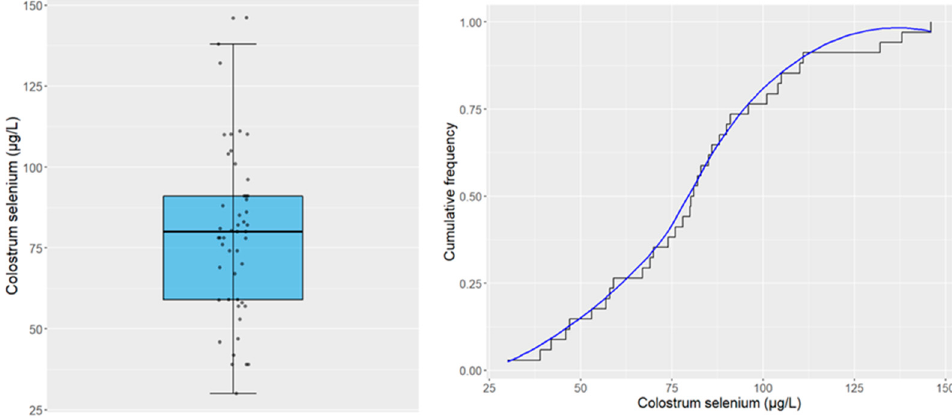
Figure 1. Colostrum selenium distribution ( left ); colostrum selenium cumulative frequency (the blue line is a Loess (locally estimated scatterplot smoothing) line) ( right ).